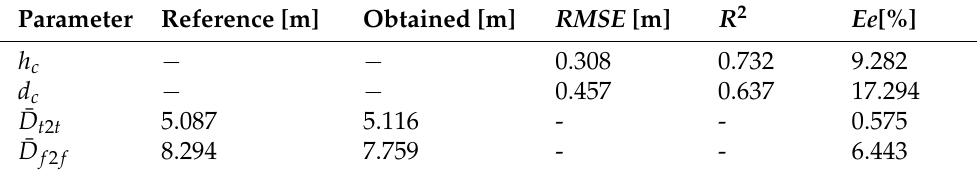
Table 5. Experimental error of obtained parameters from point cloud with respect to reference